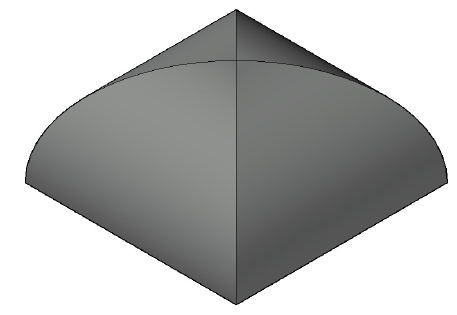
Figure 4. Three-dimensional view of the midsurface of the vault described by Equations (23) and (24). The values adopted in Equations (23) and (24) are L = 2.5 m, h = 2.13 m, and t = 0.23 m. The values have been taken by the geometry of the vault analyzed in [21], and located in the interior of Palazzo Caracciolo di Avellino in Naples. From [21] we also assume p = 8 kN/m 2 as distributed load per unit projected